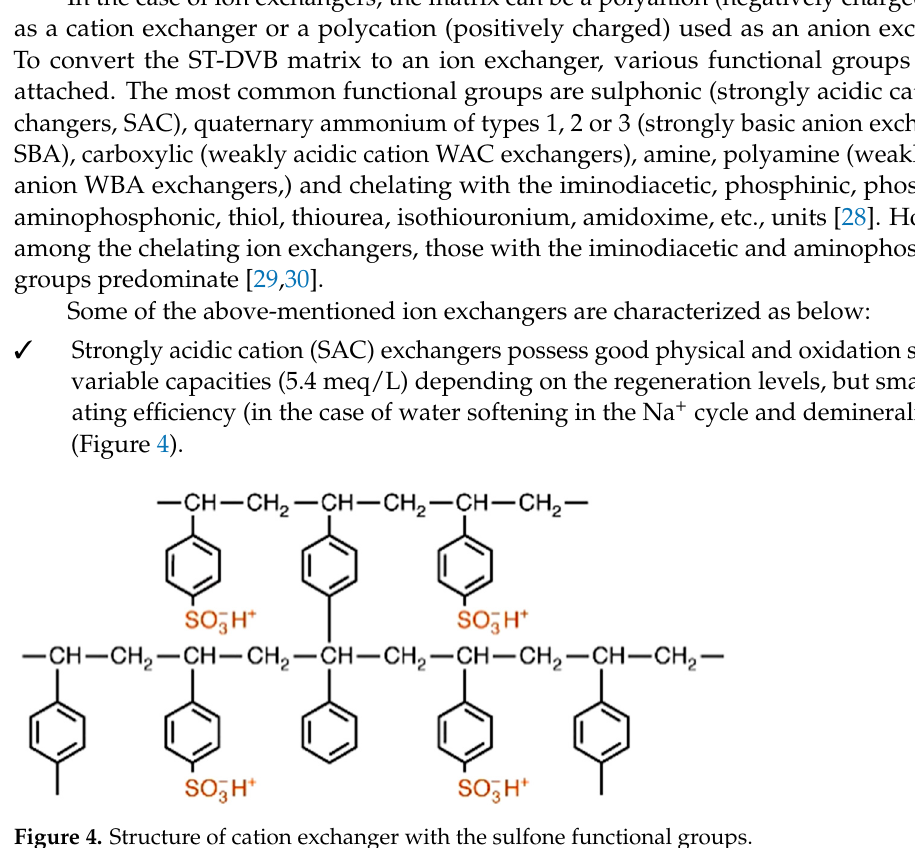
Figure 4. Structure of cation exchanger with the sulfone functional groups.